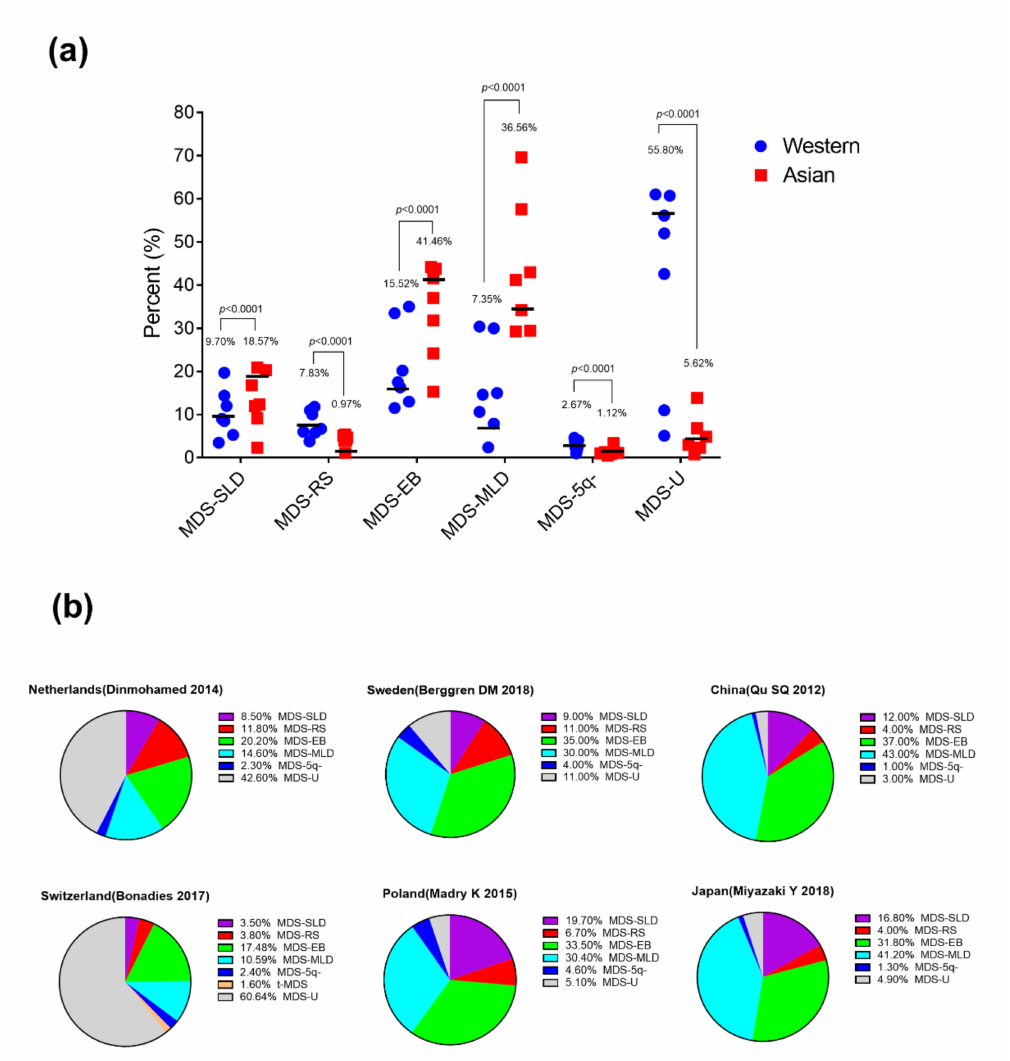
Figure 4. MDS subtypes in Western and Asian countries. ( a , b ), Percentage of MDS subtypes in Western and Asian countries. Figure 4 has been drawn based on the data and publications [10,13–15,18,19,21,24,26–31] described in Supplemental Tables S2 and S3. Importantly, the numbers indicated above each condition correspond to the weighted average (taking into account the size of the cohort of each